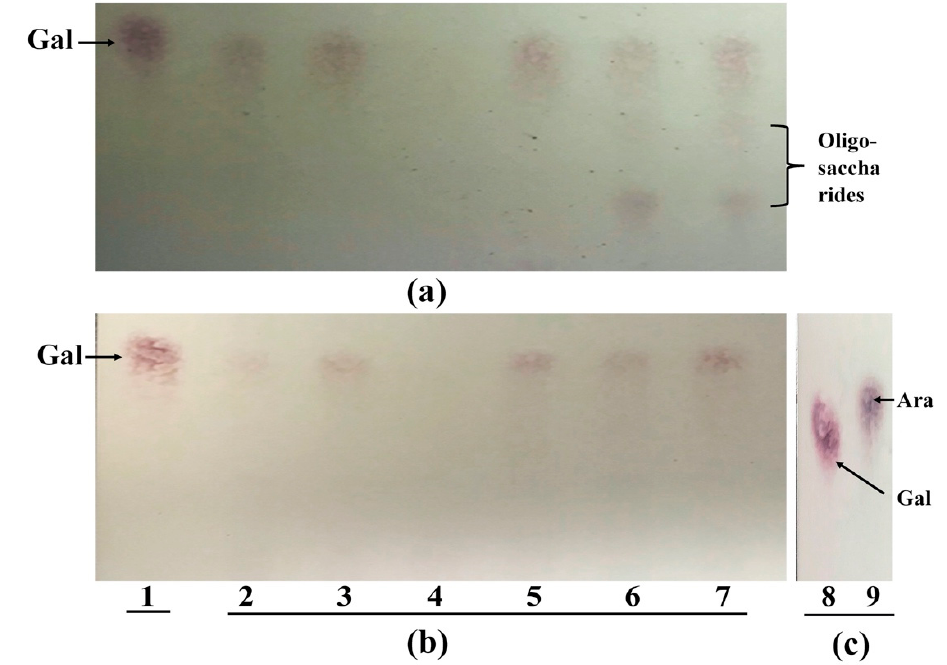
Figure 2. TLC analysis of the degradation products from cell wall-associated enzyme extracts from B. longum subsp. longum NCC 2705 ( a ) and Bac. caccae ATCC 43185 ( b ). Lane 1, galactose standard; lane 2, 3, 4, 5, 6, 7, crude cell wall-associated enzyme incubated with arabinogalactan (AG), de-arabinosylated AG (de-AG), gum arabic (GA), de-arabinosylated gum arabic (de-GA), galactan and de-arabinosylated potato galactan (de-galactan), respectively. Lane 8 and 9 from ( c ) means galactose and arabinose standard.